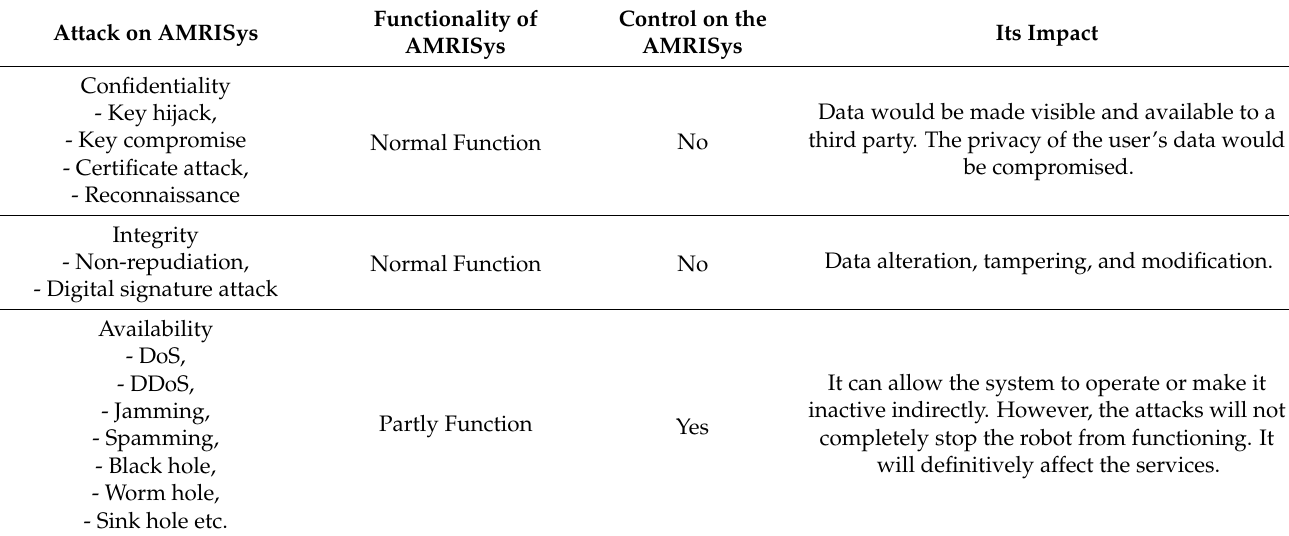
Table 4. Cyber Attack Assessment on a Multimodal Robotic